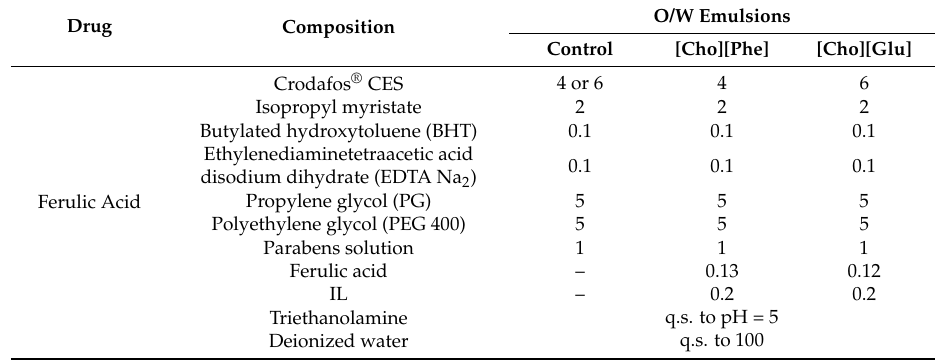
Table 1. Qualitative and quantitative composition (%, w/w ) for emulsions: with and without ferulic acid and/or each ionic liquid (IL); with and without rutin and/or each IL. O/W: